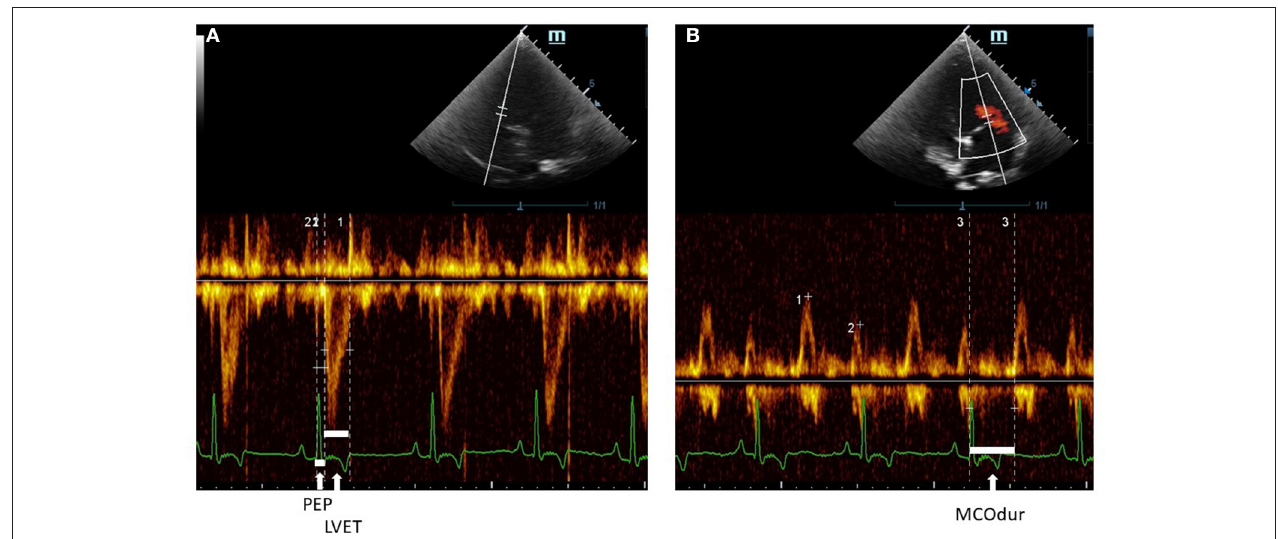
FIGURE 4 | A Pulsed-wave Doppler echocardiographic measurement of (A) PEP and LVET and (B) MCOdur through the left apical view in a dog with MMVD. The Tei index was computed from (MCOdur – LVET)/LVET. PEP, pre-ejection period; LVET, left ventricular ejection time; MCOdur, mitral valve close to open duration; MMVD, myxomatous mitral valve disease.